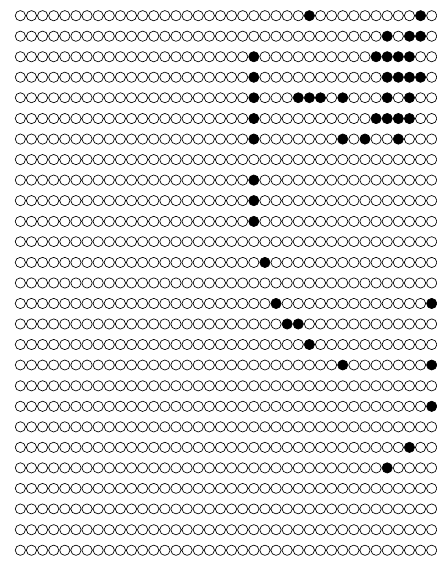
Fig.20. ANNoutputsfortheByzantineicon(black: